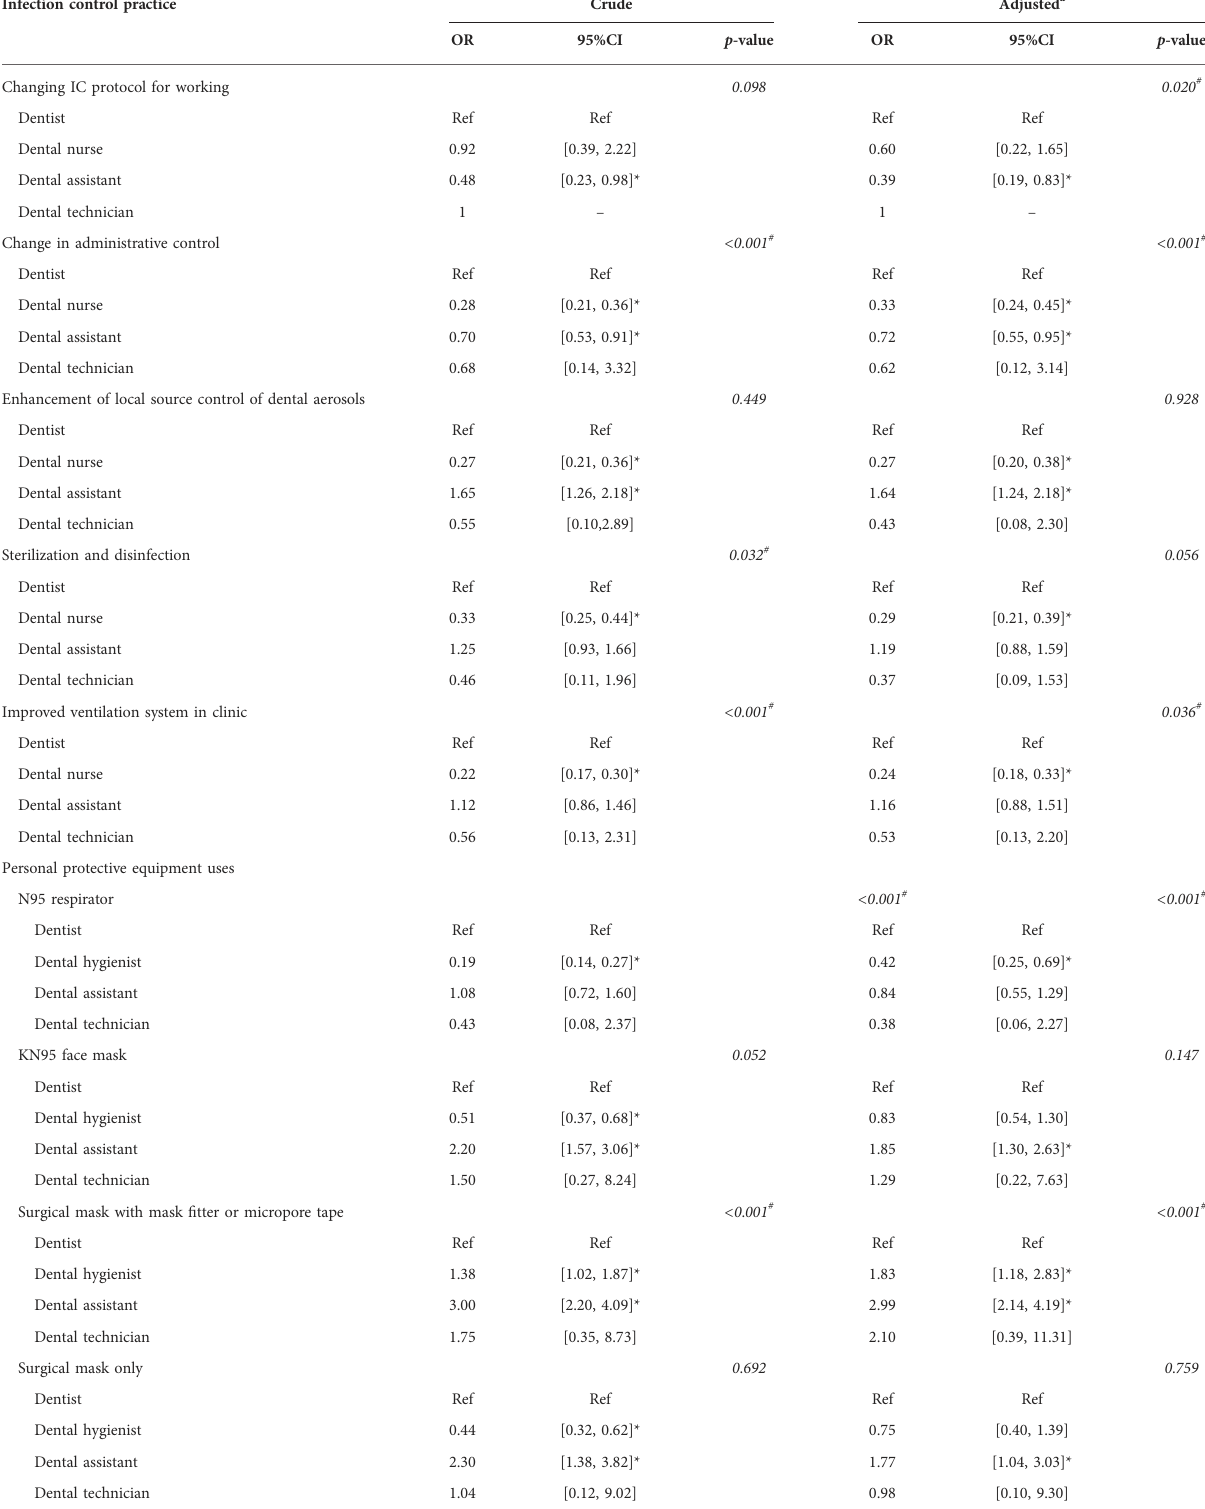
TABLE 4 Association between occupation role and infection control practice changes was analyzed both in crude and adjusted models through logistic regression analysis ( N =1177). Infection control practice Crude Adjusted a